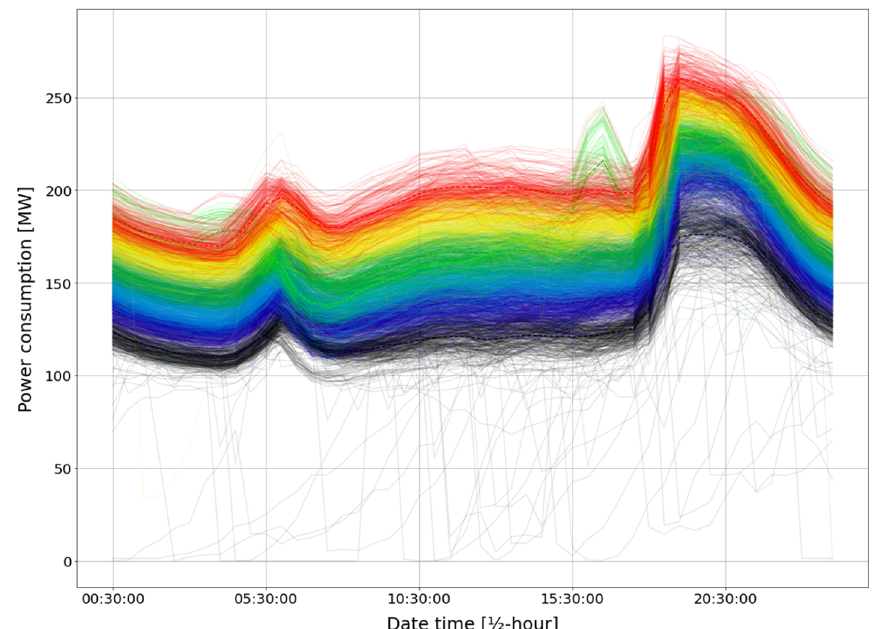
Fig. 9 Seven clusters of electricity load profiles for Lombok, Indonesia, from 2015 to